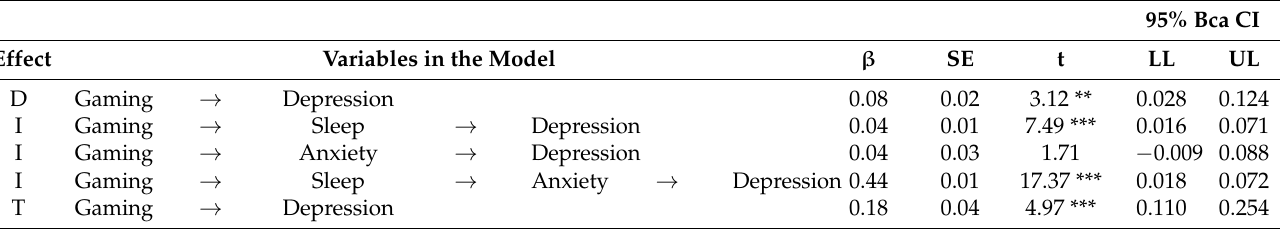
Table 7. Model 2 of mediating effects of sleep quality and anxiety on the relationship between gaming and depression in the sample of undergraduates ( n = 457).